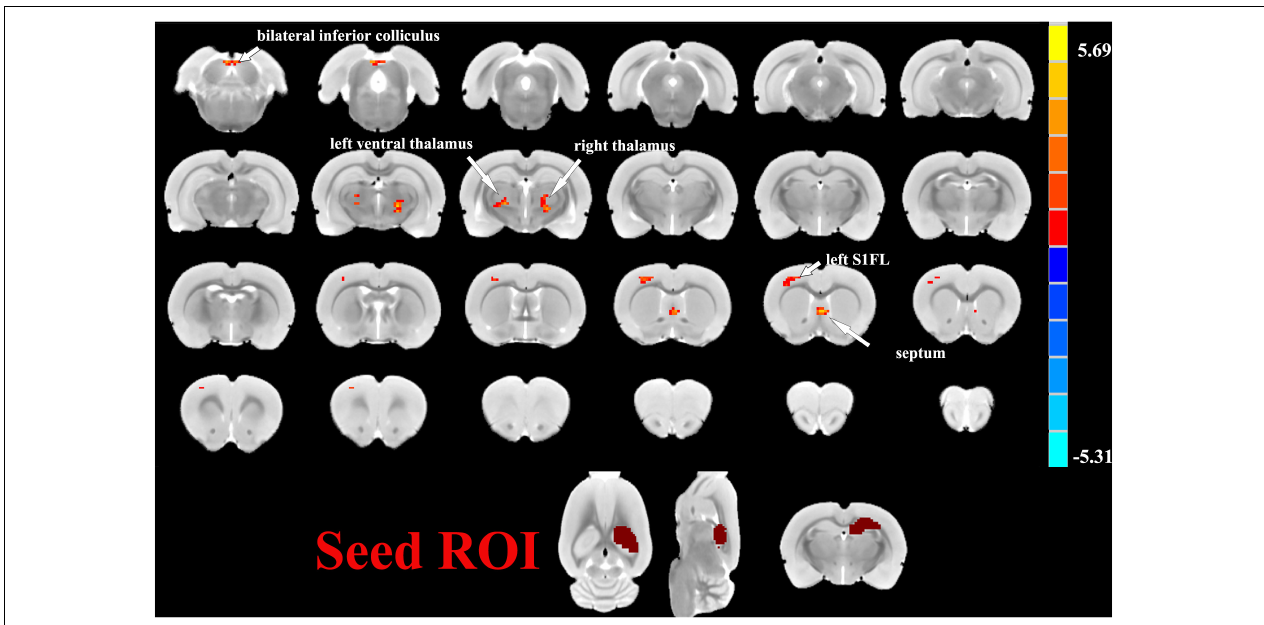
FIGURE 5 | Two sample t -test functional connectivity (FC) analysis selecting the right hippocampus as seed between the SAE and control groups. With the right hippocampus as the seed brain region, the SAE group displayed enhanced FC between the right hippocampus and thalamus, septum, left primary forelimb somatosensory cortex (S1FL), and inferior colliculus.